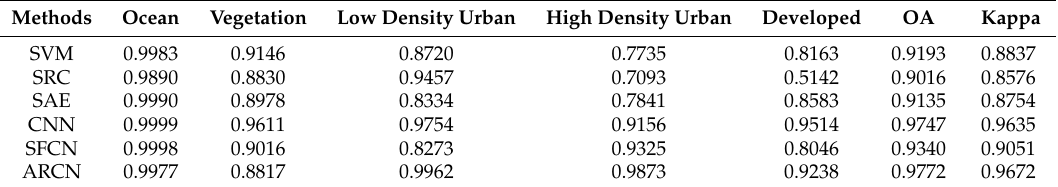
Table 3. Classification results of San Francisco with various methods.